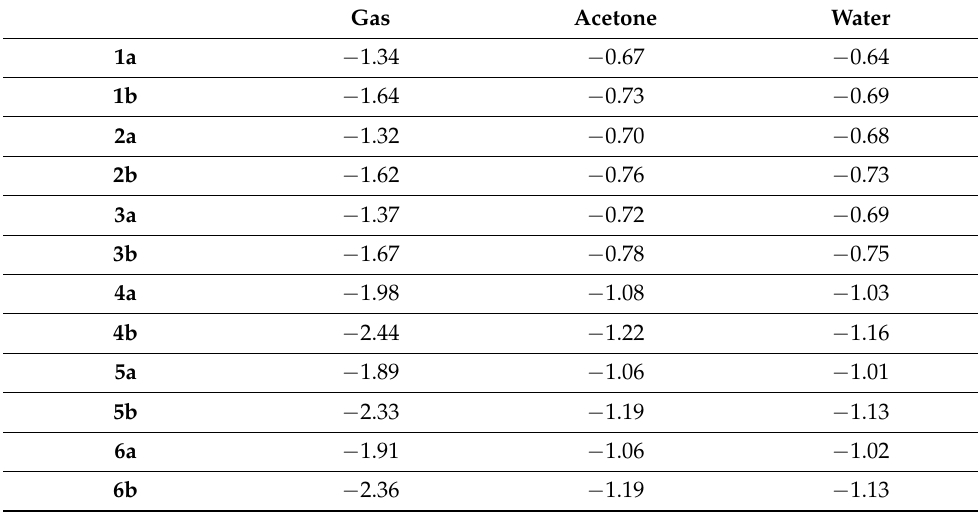
Table 3. Interaction energies (kcal/mol) of chalcogen bonded dimers. MP2/aug-cc-pVDZ values corrected for